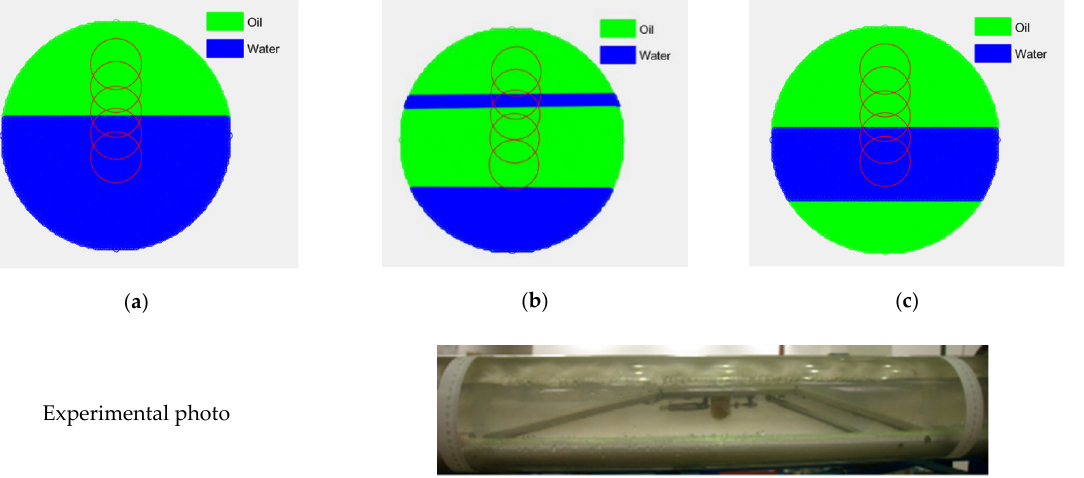
Figure 11. Smooth stratified flow holdup imaging (OW-PD88L50CW20); ( a ) Inverse distance weight interpolation; ( b ) Radial basis function interpolation; ( c ) Kriging interpolation .